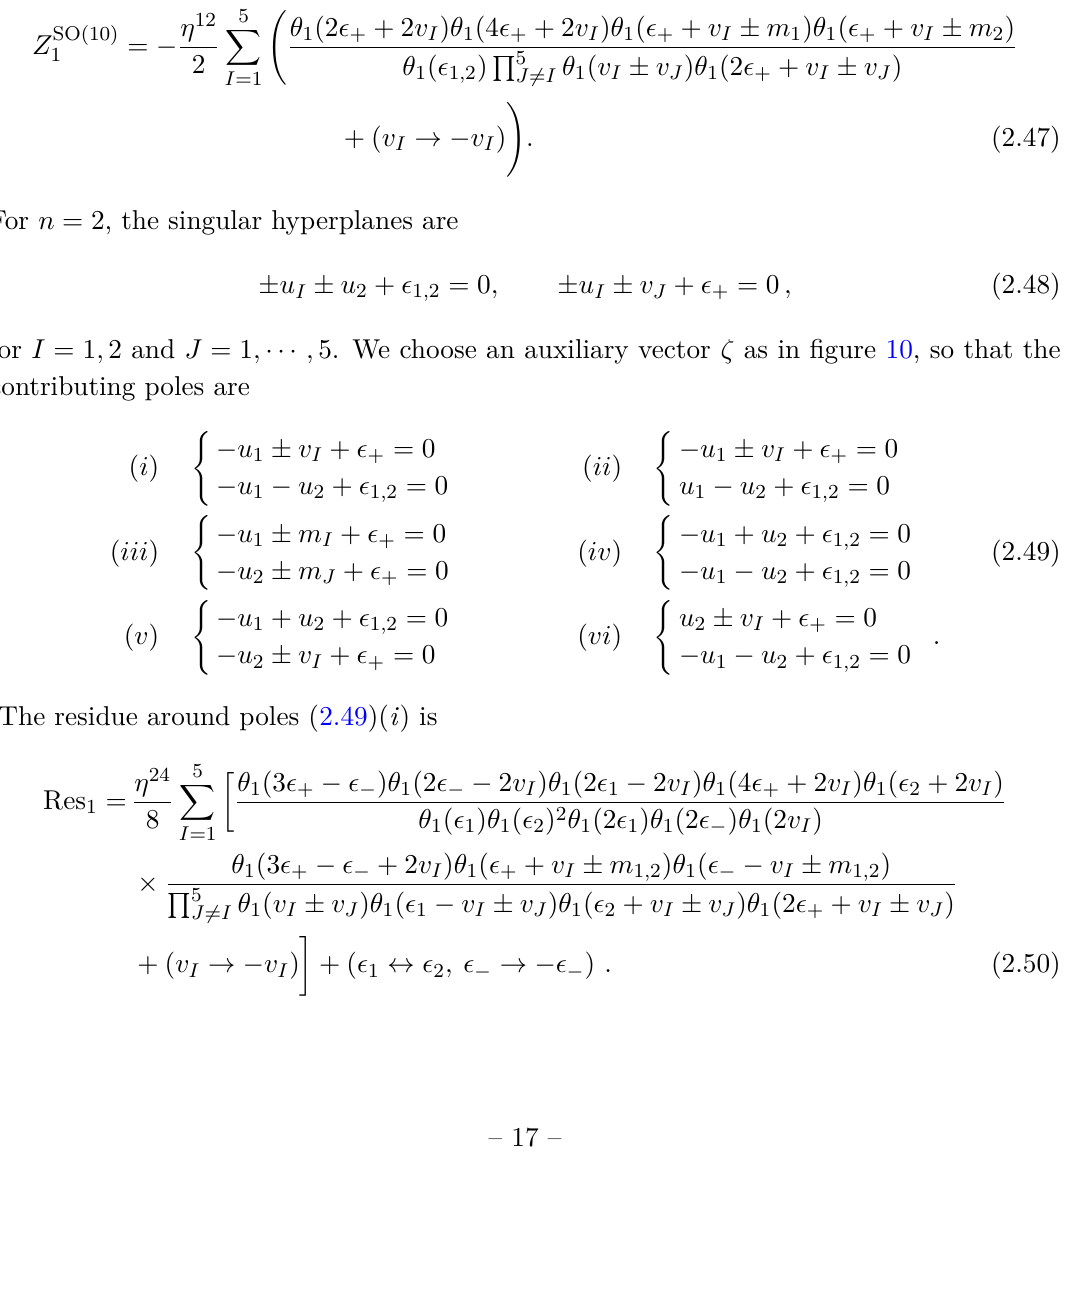
Figure 10. A choice of an auxiliary vector ζ for JK-residue calculation of two-string elliptic genus. the one-string elliptic genus